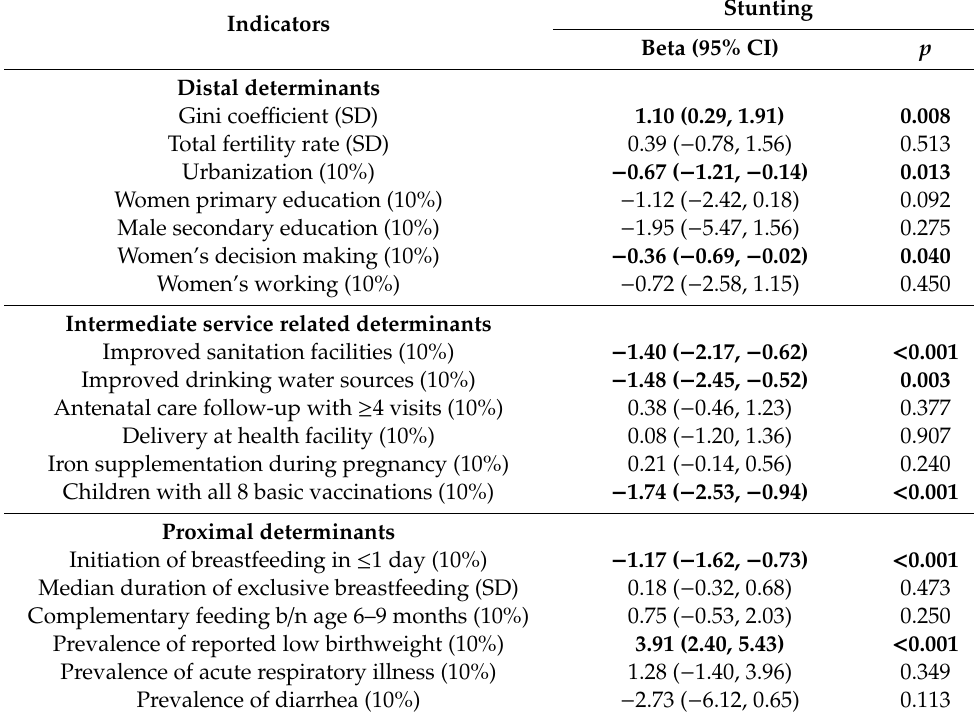
Table 4. Modeling distal, intermediate, and proximal drivers of trend in stunting prevalence 1